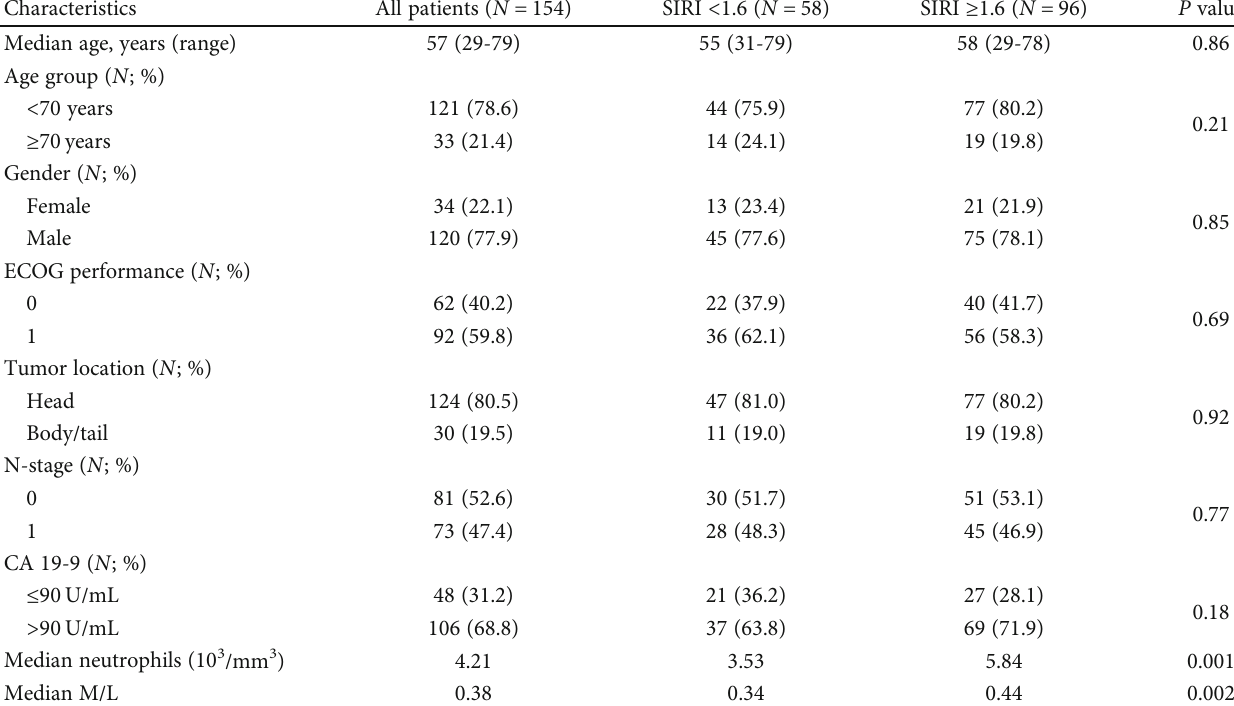
Table 1: Baseline patient and disease